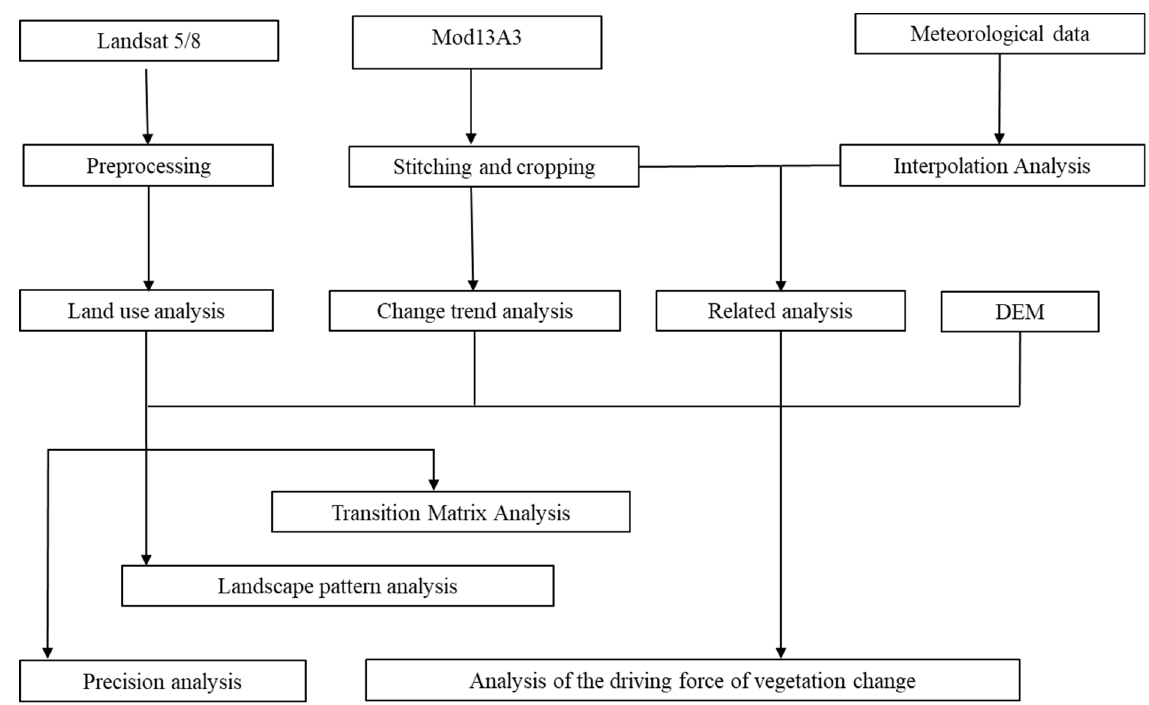
Figure 2. Data processing and analysis flow chart.